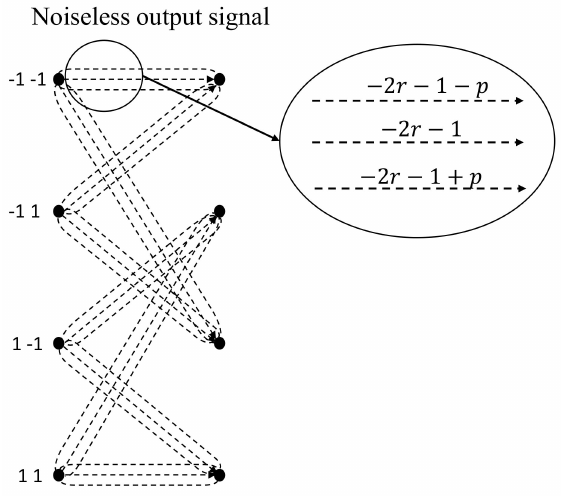
Figure 4. Trellis diagram for the modified Viterbi algorithm